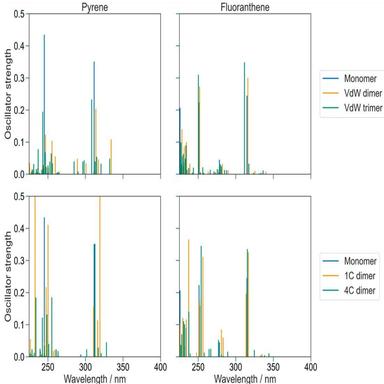
Low-lying electronic transitions of pyrene and fluoranthene monomers (blue) compared to their homo-dimers (orange, top), homo-trimers (green, top), 1C dimers (orange, bottom) and 4C dimers (green, bottom).